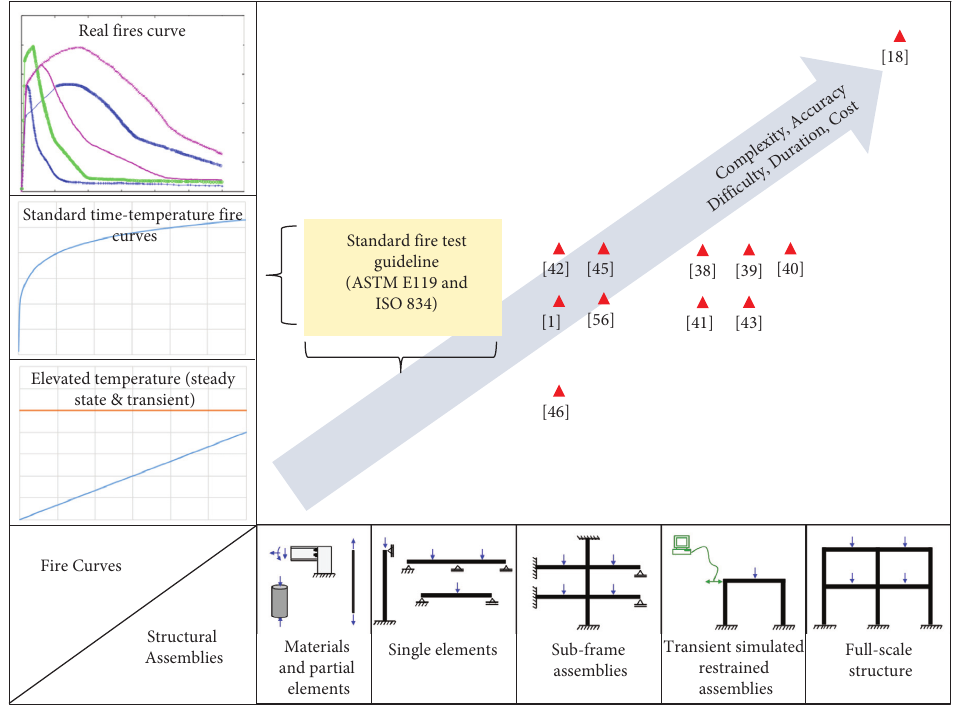
Figure 6: The relationship performance of fire tests based on different fire curves and structural